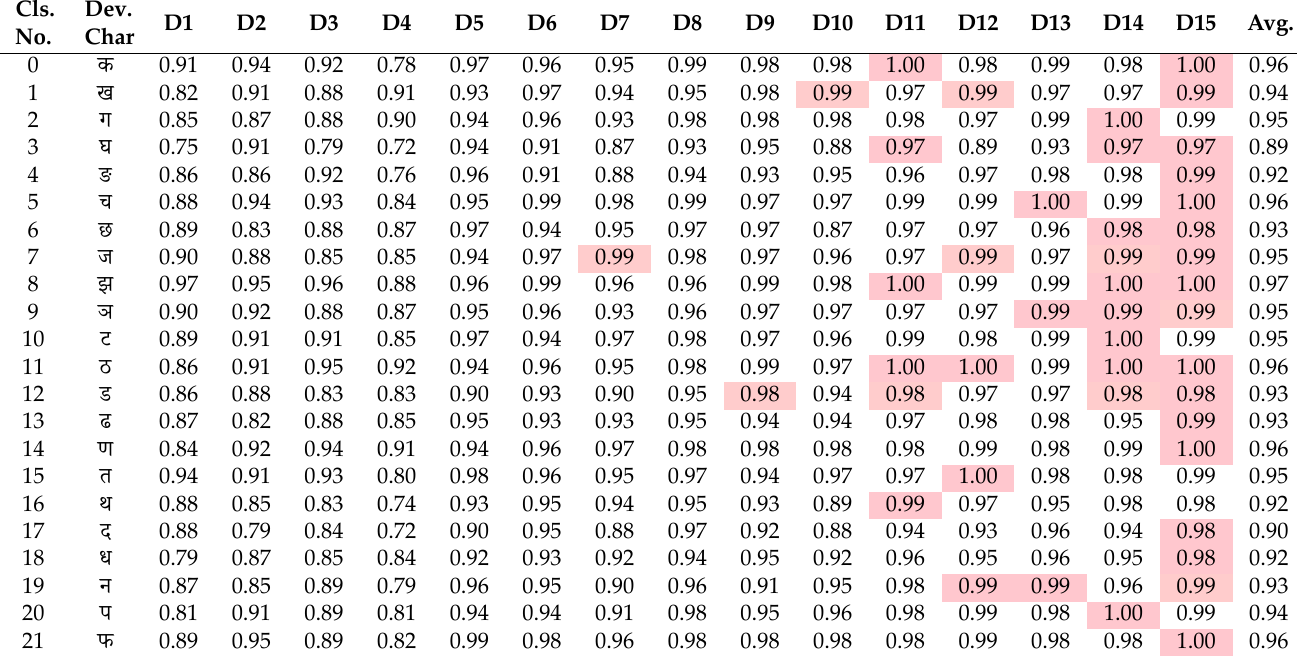
Table 9. Character‑wise F1 score produced by an MLP classifier for the proposed datasets.